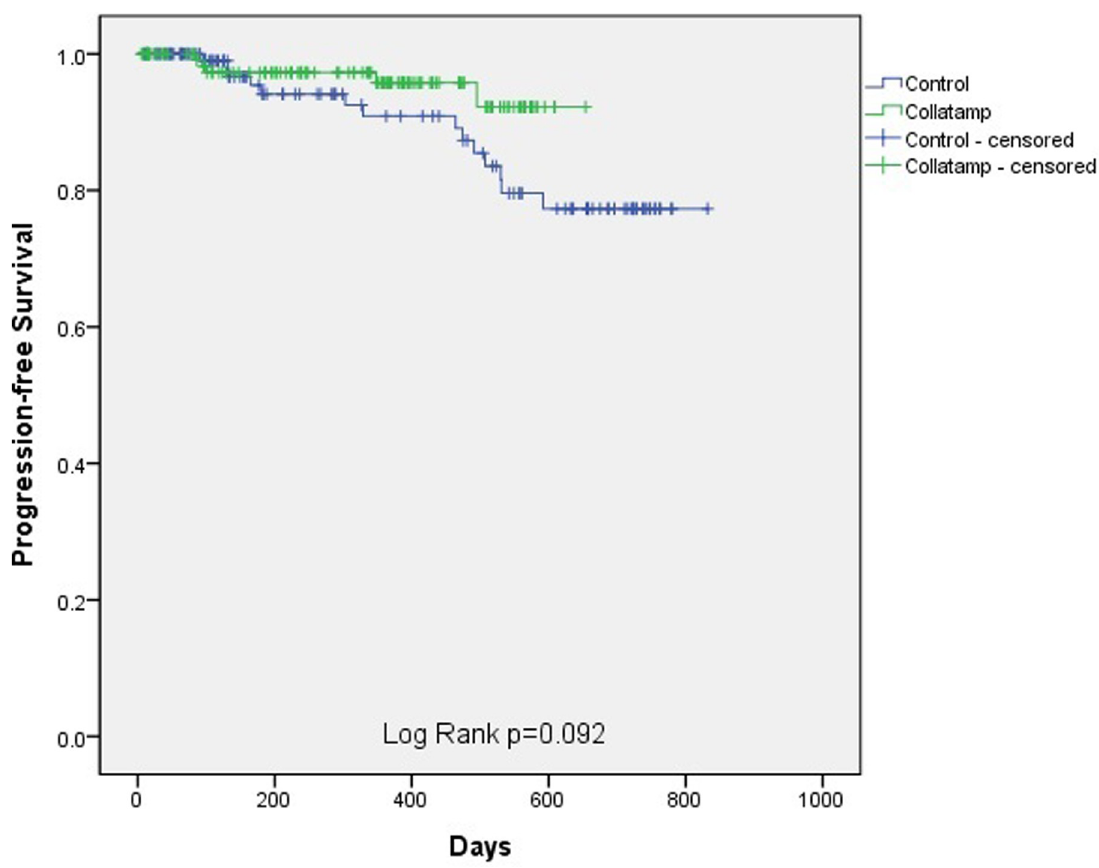
Fig 2. Progression-free survival between the Collatamp group and the control group. There was no significant difference in the estimated 2-year progression-free survival rate between the two groups (log-rank p-value = 0.092).